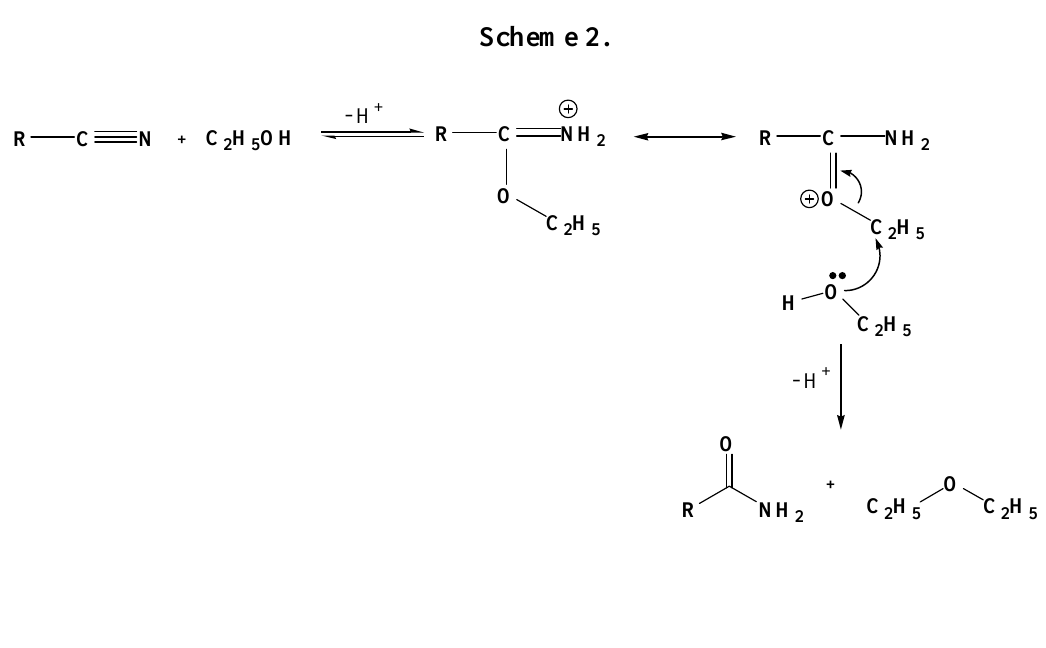
Table 1. Electronic absorption and fluorescence data of compounds 3-8 in EtOH.